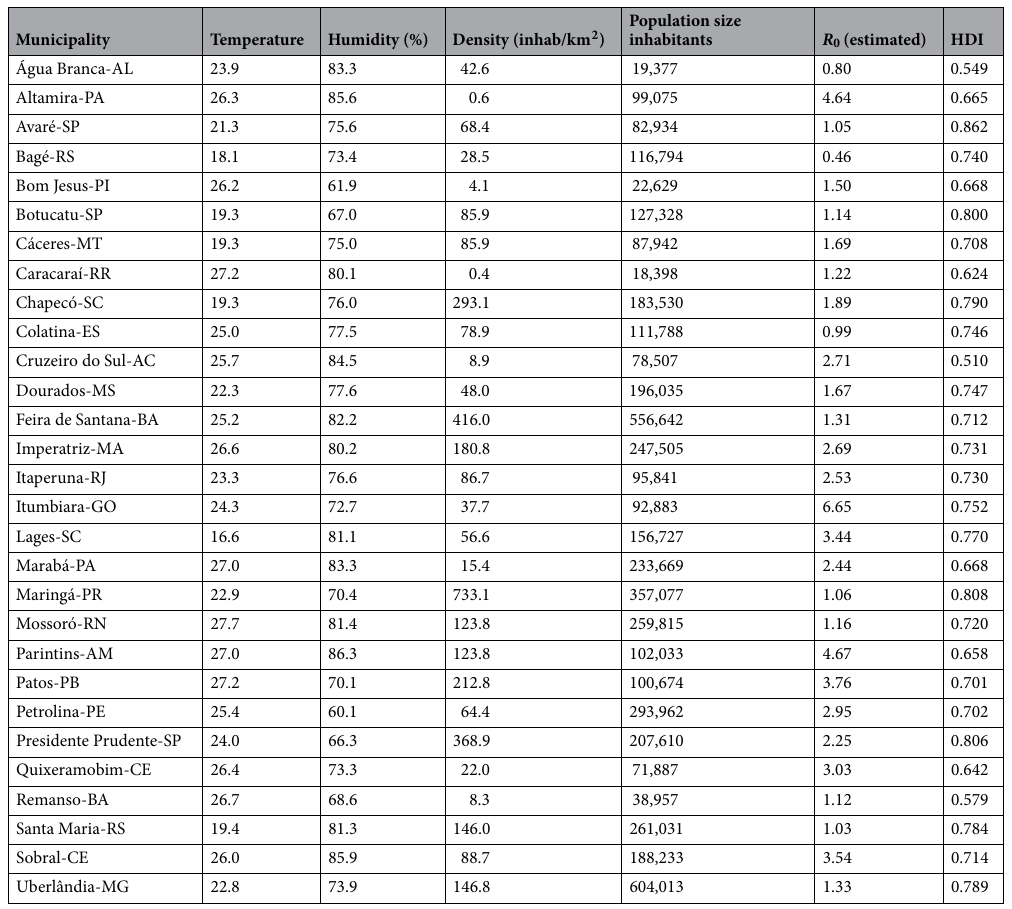
the average one observed in April month in each locality 31 . The other factors like density, population size, and Human Development Index (HDI) come from government’s website 13 ; R 0 are estimated from data 32